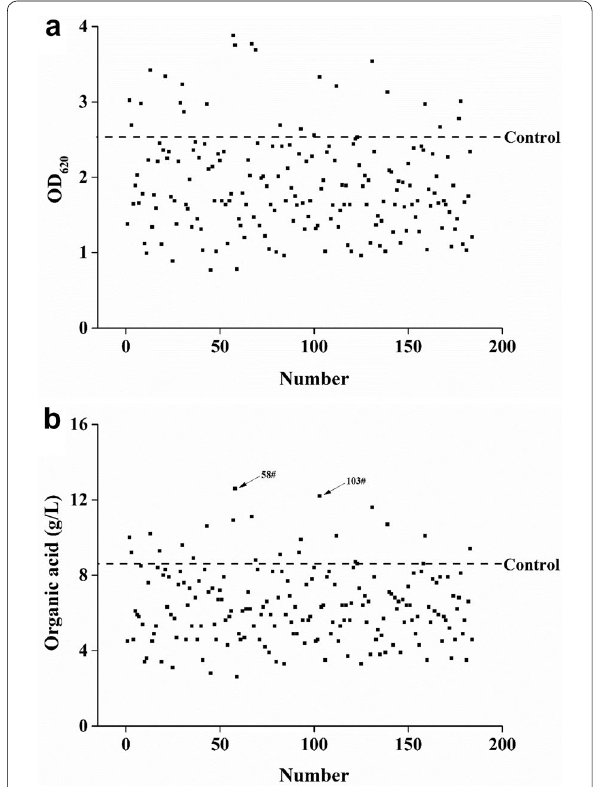
Fig. 7 Comparison of cell growth ( a ) and organic acid production ( b ) with the mutant strains and the parent strain during preliminary